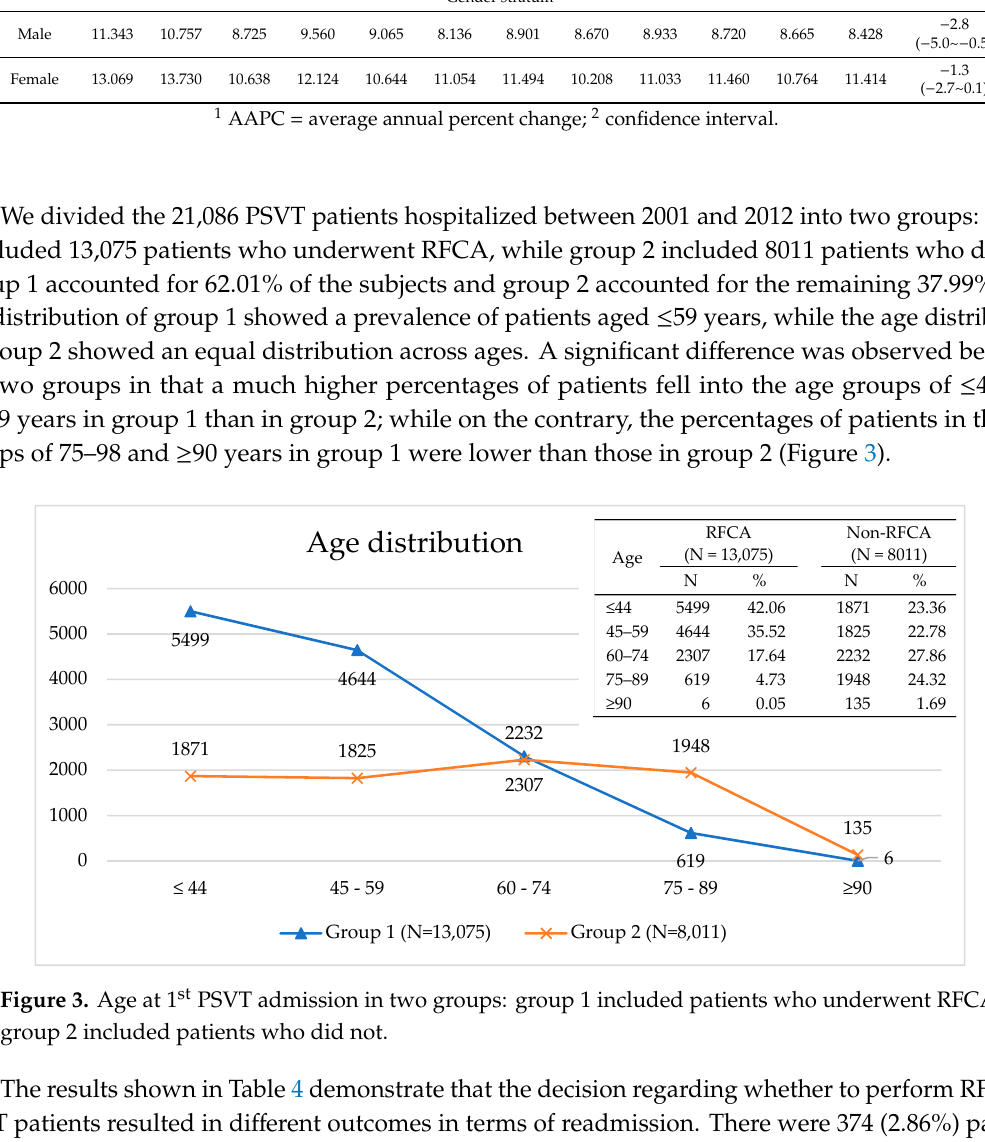
Table 4. Relative risk of PSVT ‐ related readmission in patients who underwent RFCA and those who did not.